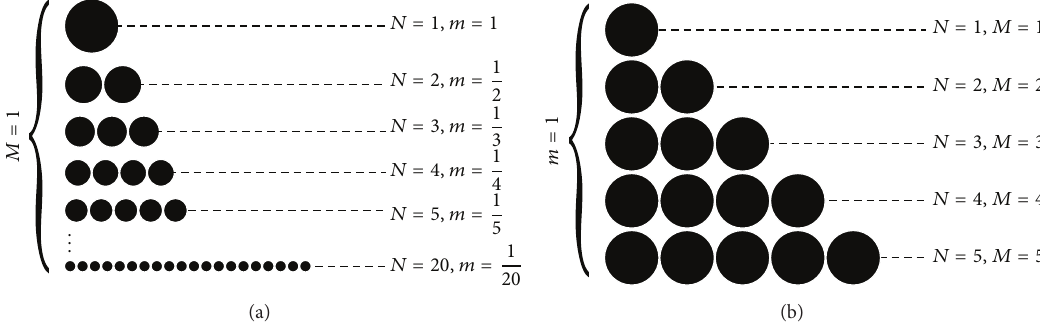
Figure 1: (a) Classical mean field point of view, in which the total mass 𝑀 of the system is constant while the mass 𝑚 of each particle becomes infinitesimal as 𝑁 increases. (b) The point of view pursued in this paper, in which 𝑚 is constant ( massive particles ) while 𝑀 grows when 𝑁